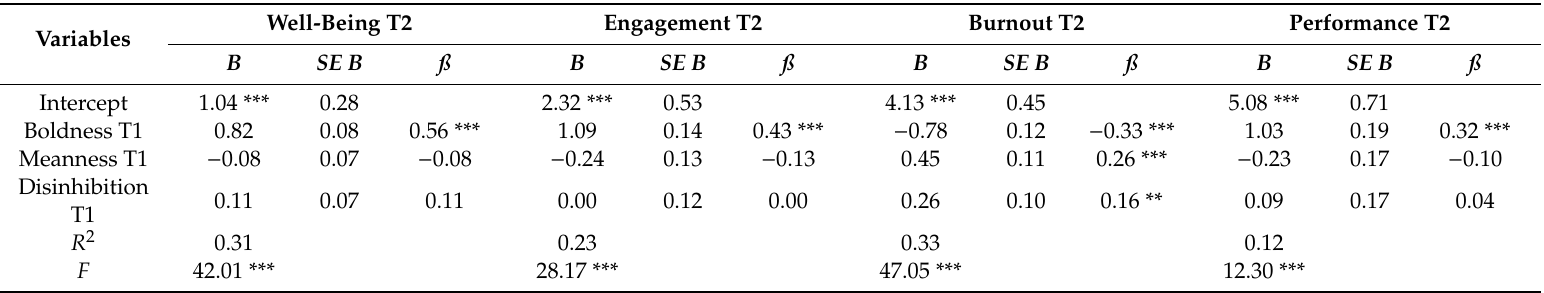
Table 6. Regression analyses of self-reported psychopathy (Time 1) predicting well-being, engagement, burnout and performance (Time 2). Well-Being T2 Variables Intercept